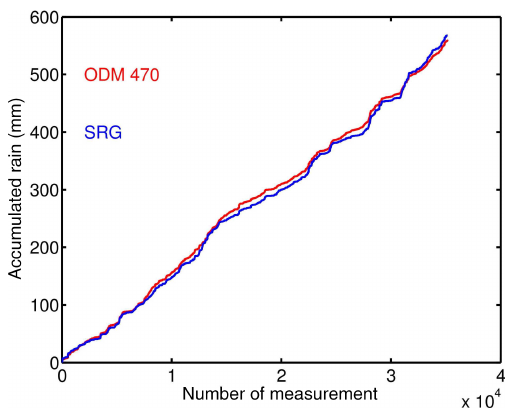
Figure 1. Comparison of simultaneous measurements of precipita- tion (rain only) on board R/V Alkor in the Baltic Sea (data from 1999 to 2005, May to October) using an ODM 470 and a SRG. The interval of measurements is